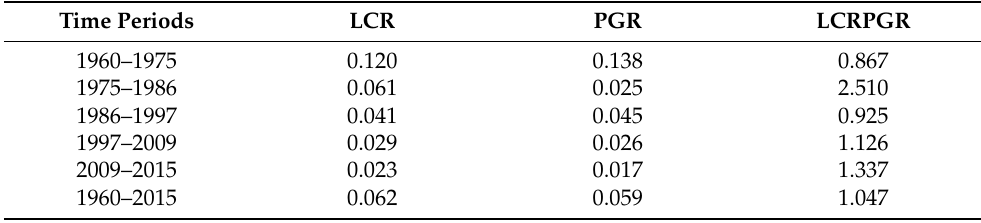
Table 5. Land consumption rate, population growth rate, and land-use efficiency in the FDB during 1960–2015.